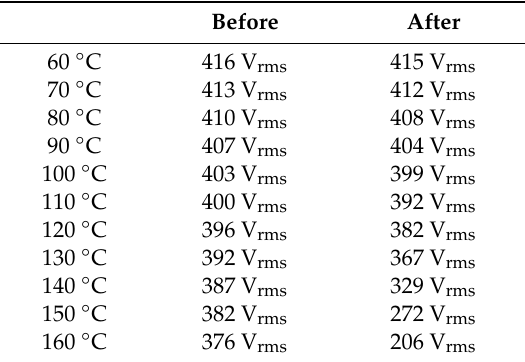
Table 3. Back EMF at 1500 rpm before and after the three-phase short circuit. Before After